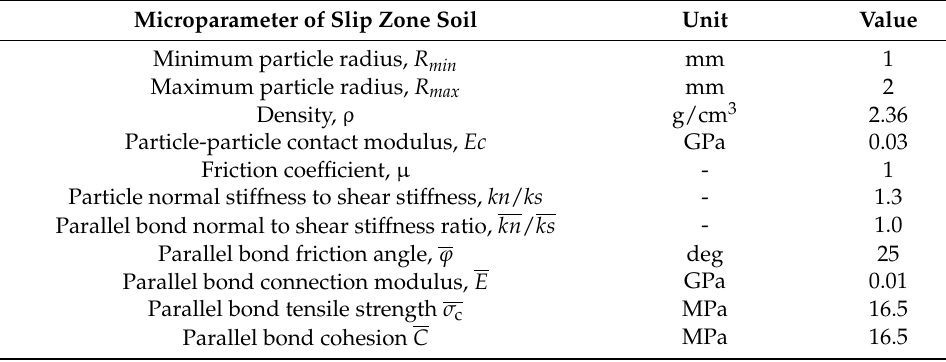
Table 1. Calibrated microscopic parameters of PFC3D